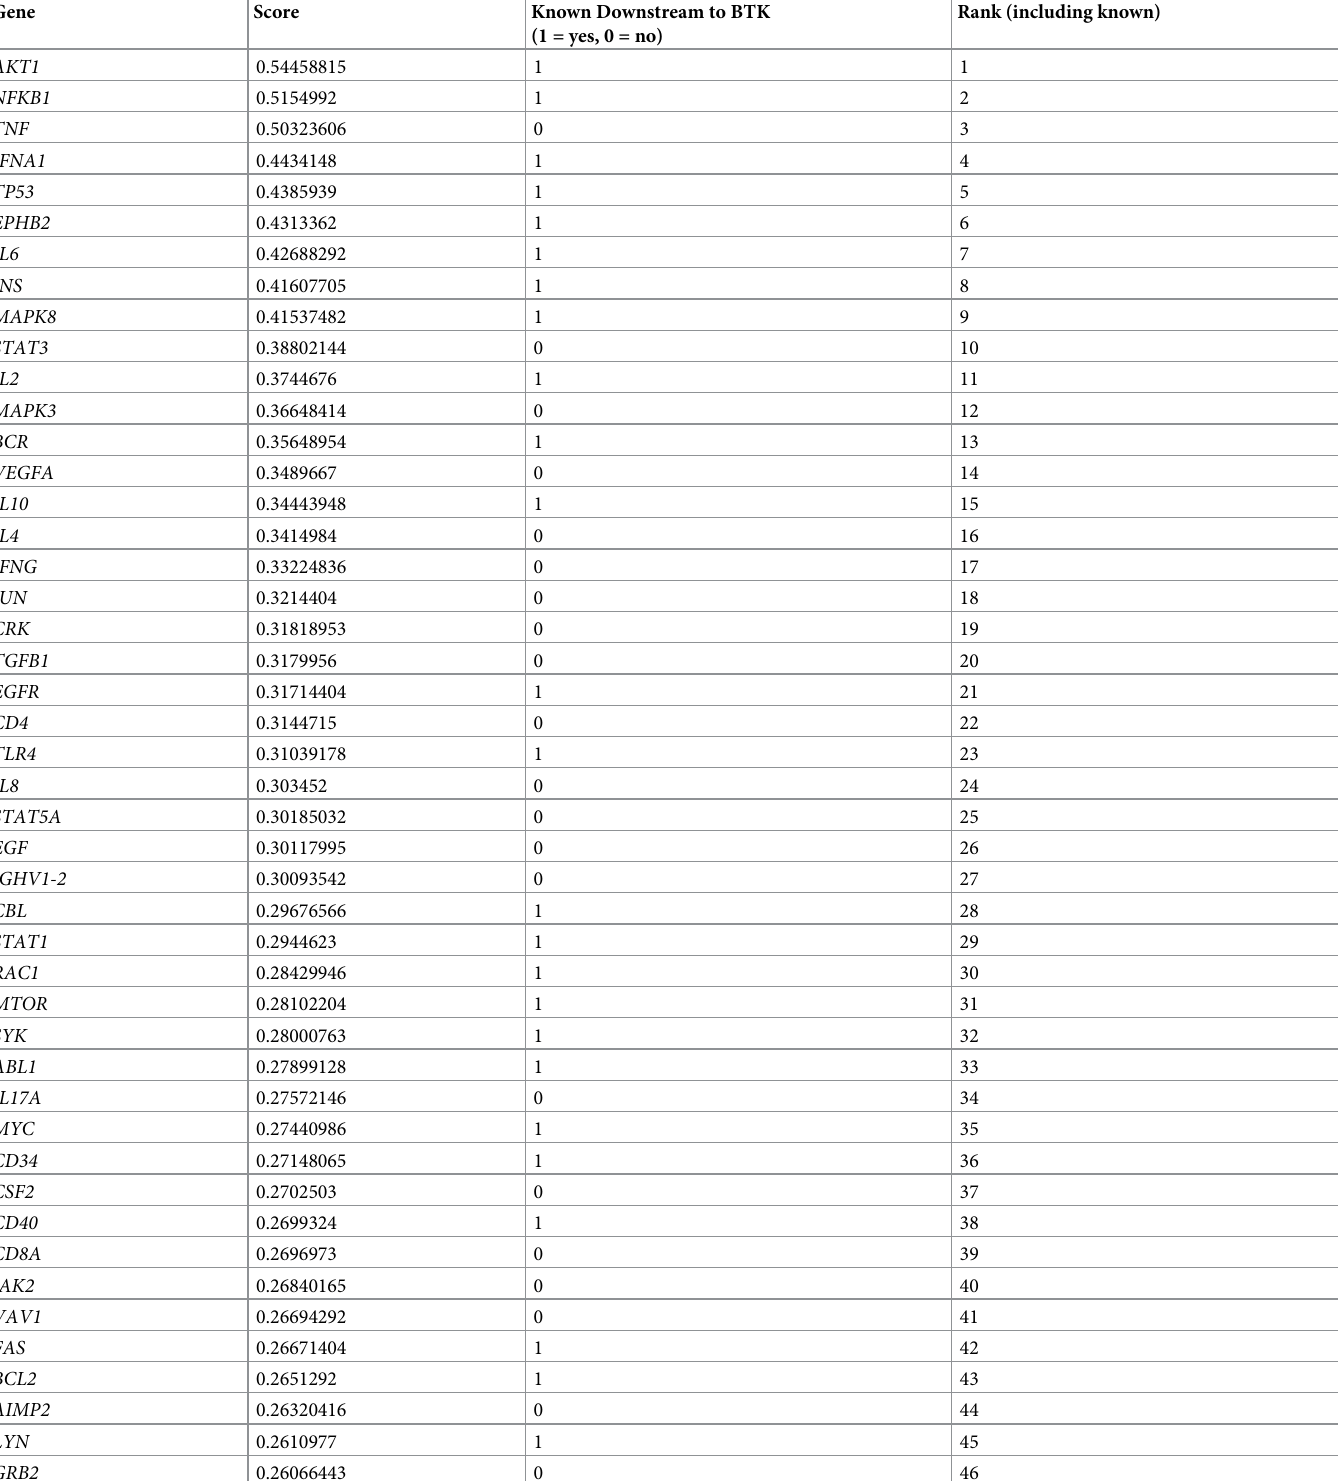
Table 2. Top 50 genes predicted by WDD to be downstream of